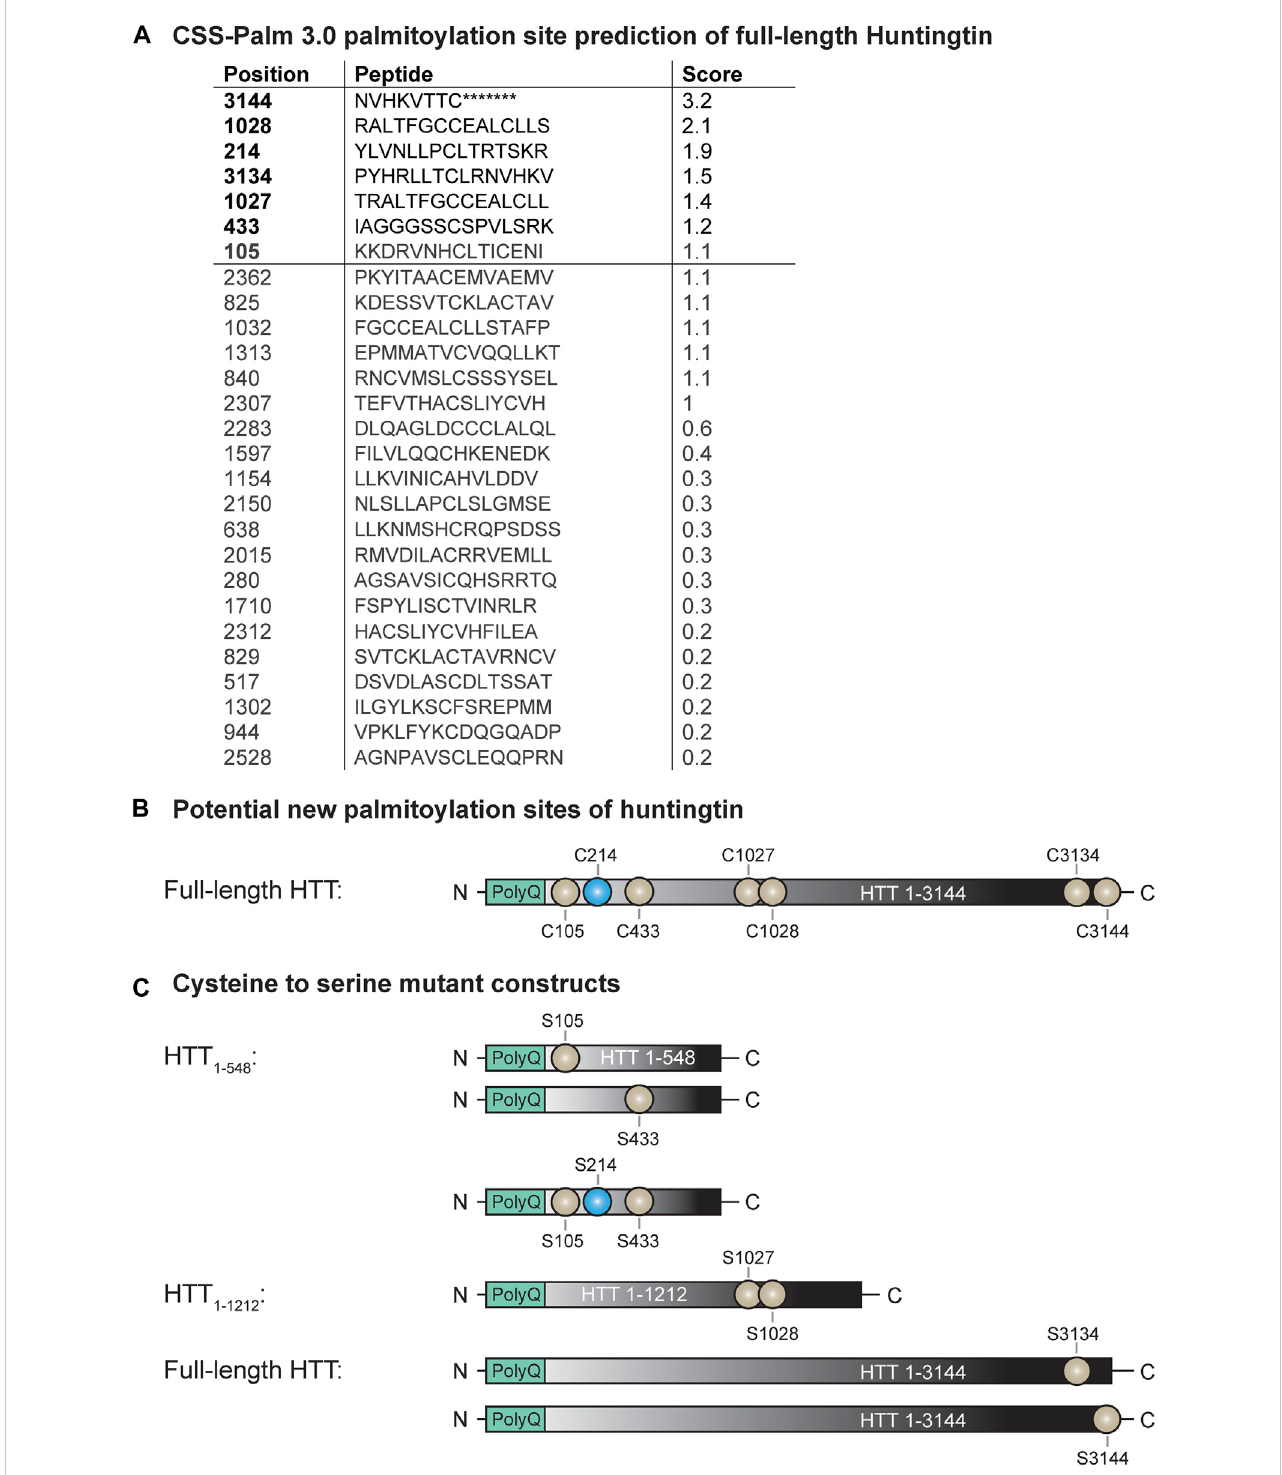
FIGURE 1 Potential newpalmitoylationsitesofhuntingtin. (A) CSS-Palm3.0palmitoylationsitepredictionoffull-lengthHTT, (B) palmitoylationsiteofHTT(inblue: C214) and potential new palmitoylation sites investigated in this study (in light grey: C105, C433, C1027, C1028, C3134 and C3144), (C) cysteine-to-serine